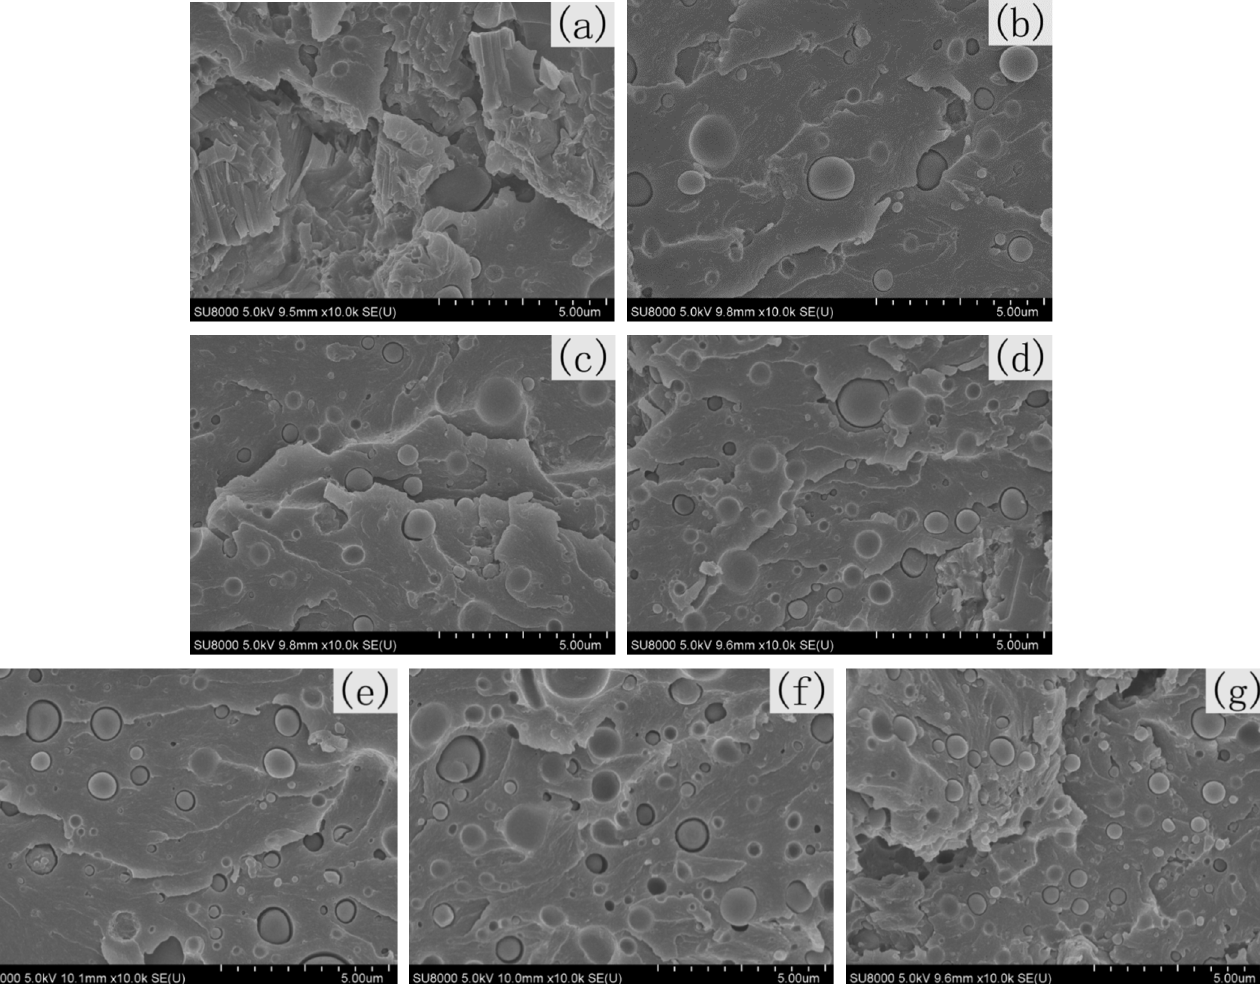
Figure 8. SEM image of RL/IFR film membrane cross section: ( a ) RL, ( b ) RL/5%IFR, ( c ) RL/10%IFR, ( d ) RL/15%IFR, ( e ) RL/20%IFR, ( f ) RL/25%IFR, and ( g ) RL/30%IFR.